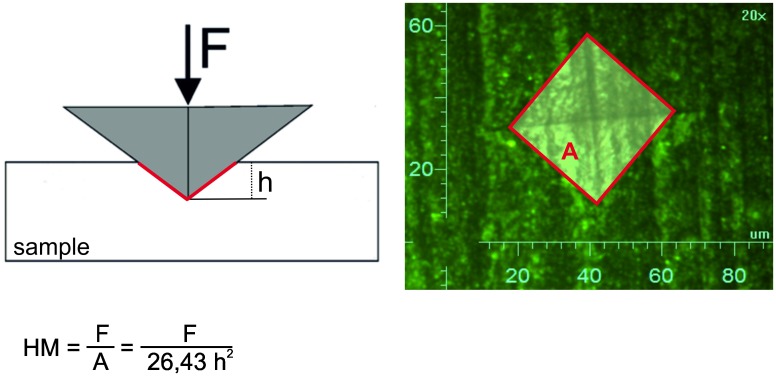
Measurement principle and calculation of Vickers microhardness.